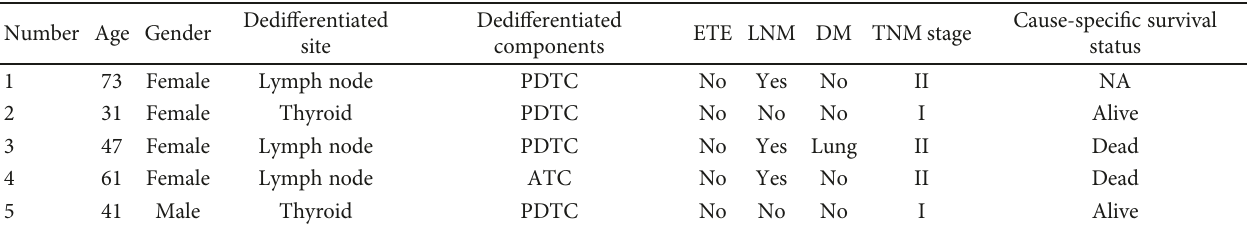
Table 6: Clinicopathological characteristics of PTMC patients with dedi ff erentiated